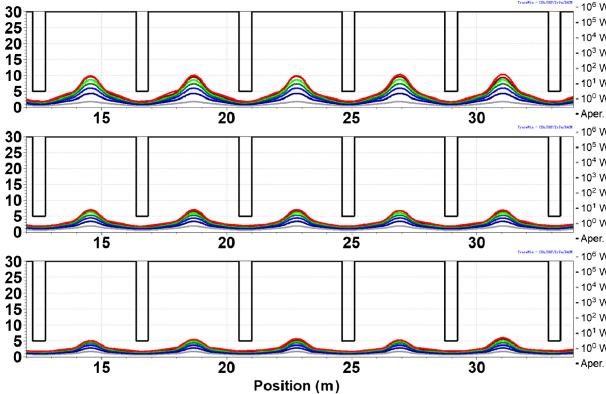
FIG. 8. Power density level in VDS. (Y-axis indicates radius in mm, from top to bottom: beam energy E ¼ 500 , 1000, 1500